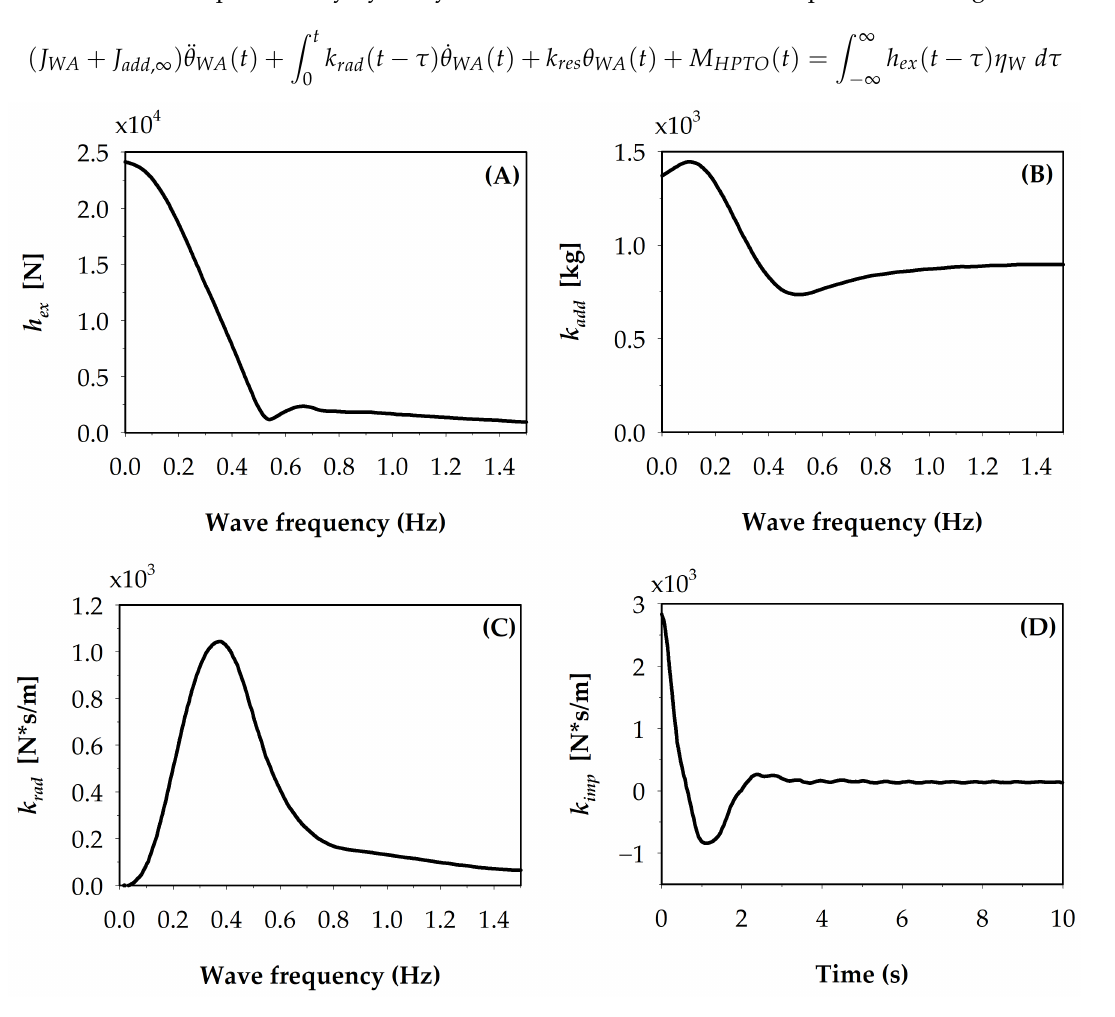
Figure 7. Hydrodynamic parameters of wave absorber device from preliminary simulation in ANSYS/AQWA. ( A ) Excitation force coefficient; ( B ) Added mass coefficient; ( C ) Radiation damping coefficient; ( D ) Impulse response